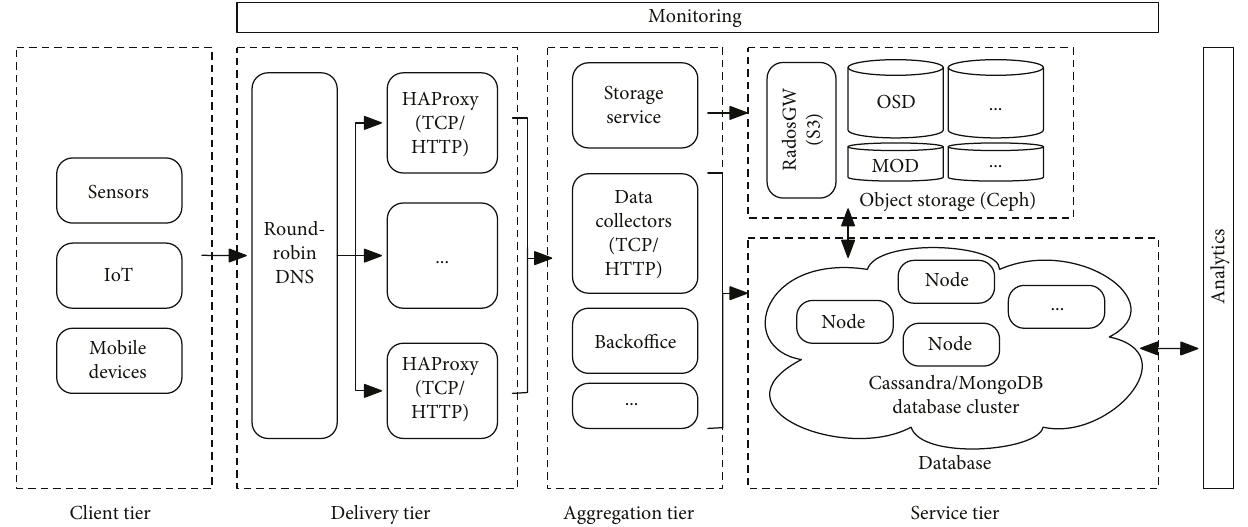
Figure 2: General architecture of the